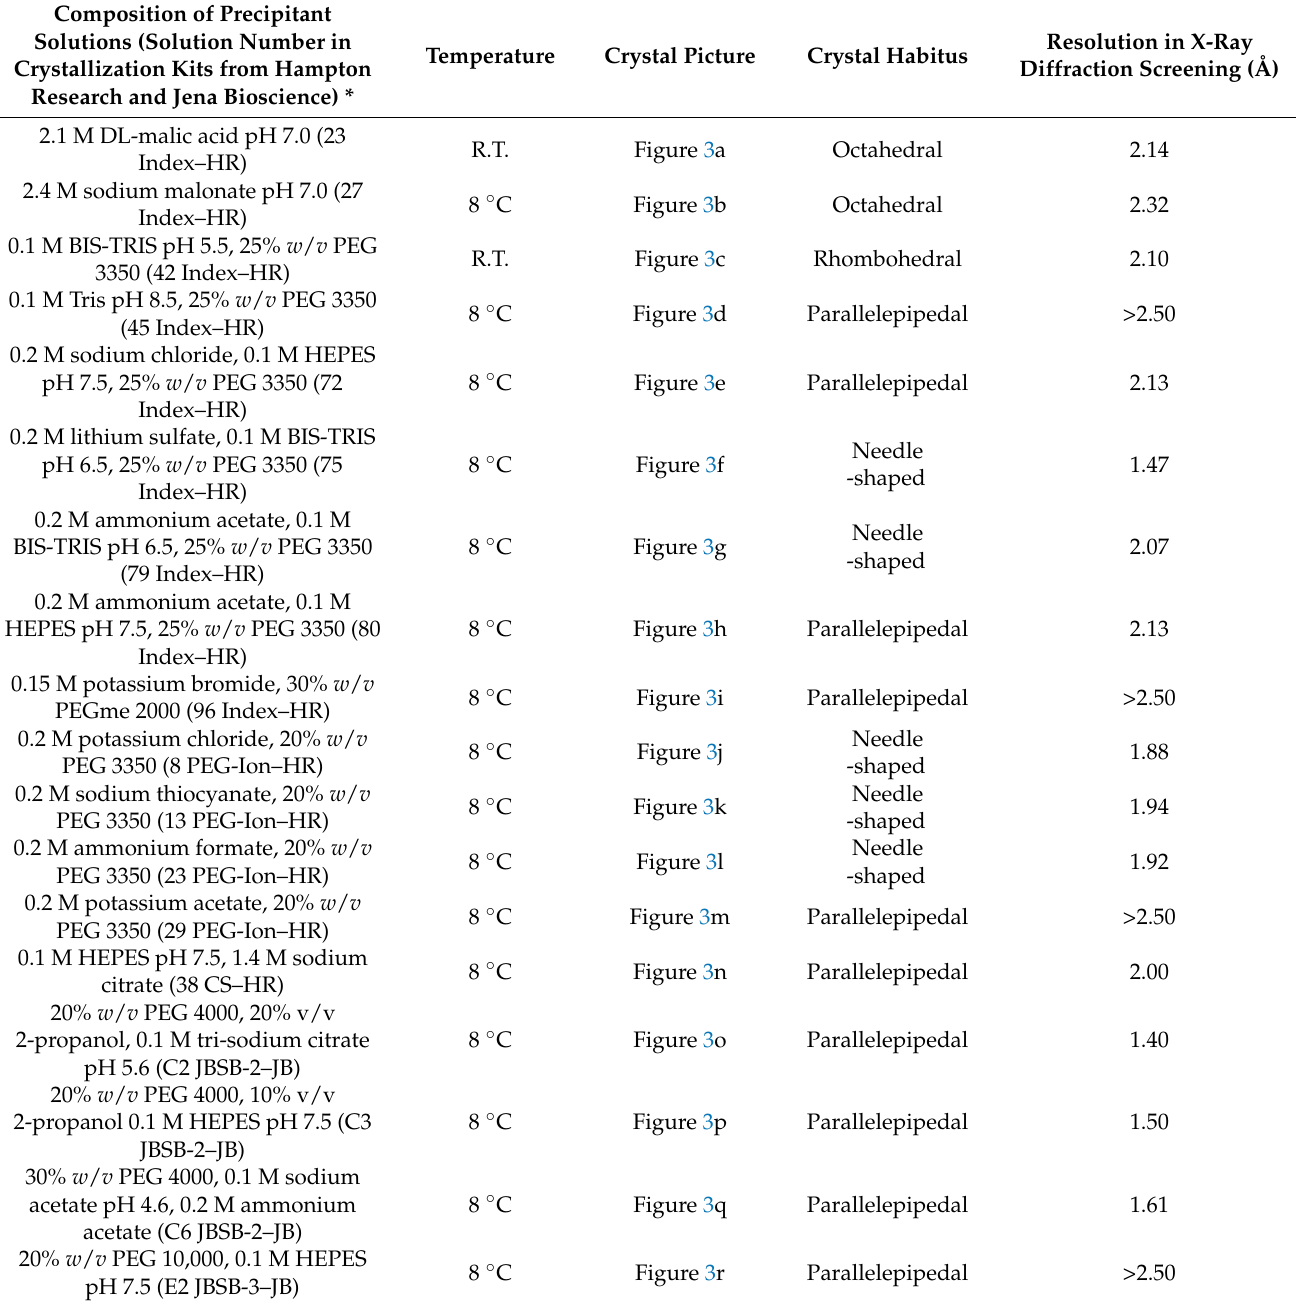
Table 1. Precipitant compositions and crystallization conditions applied to obtain the eighteen cL-BABP crystal samples selected for the X-ray crystallographic screening.